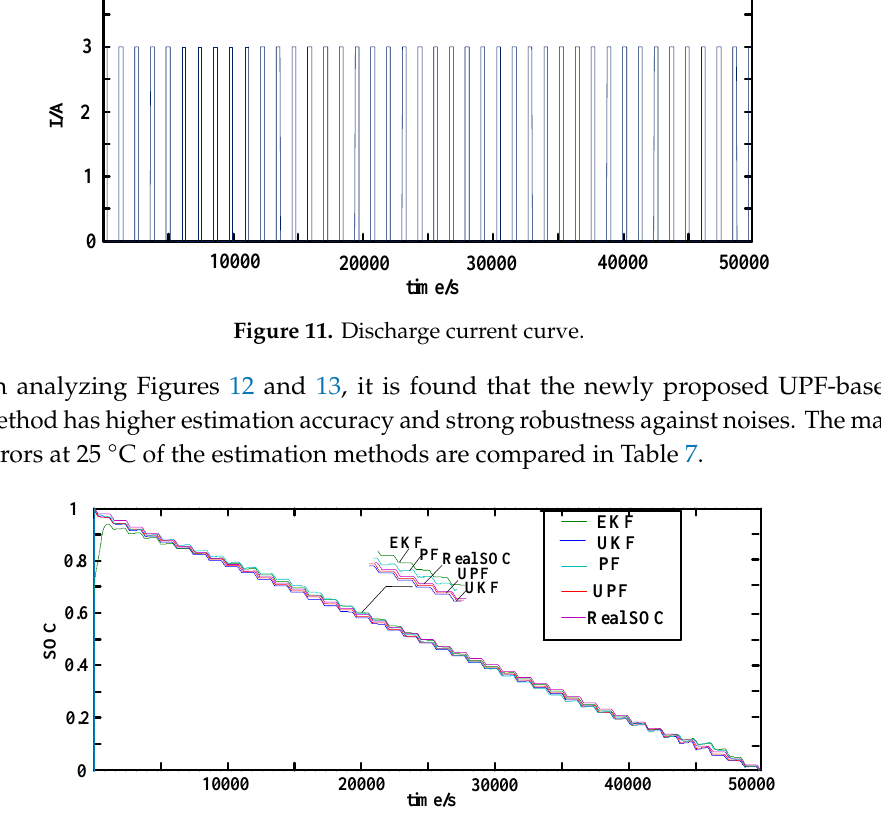
unscented Kalman filter; PF, particle filter, UPF, unscented Kalman particle filter. Figure 12. SOC Estimation curves of di ff erent algorithms at 25 ◦ C. EKF, extended Kalman filter; UKF,